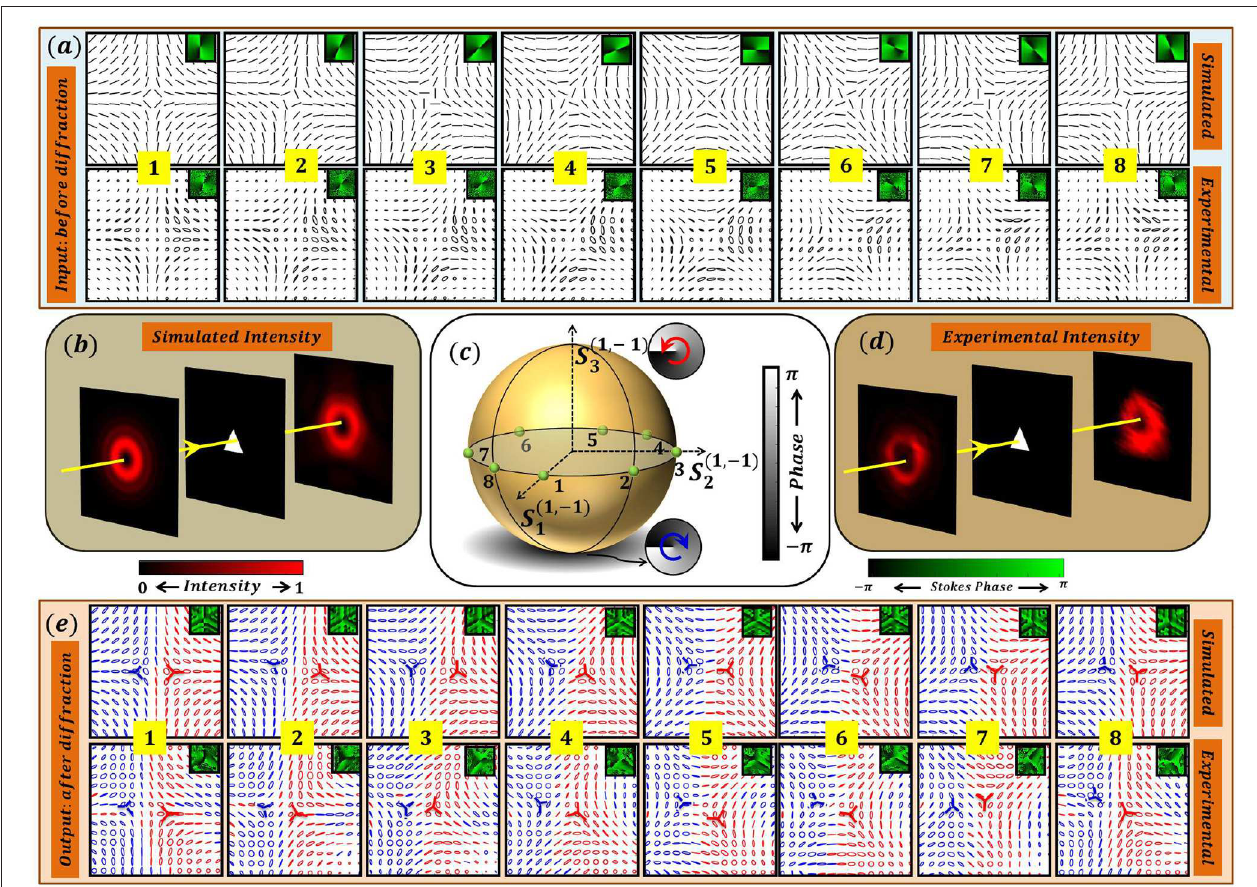
FIGURE 14 | Intensity degeneracy in the diffraction patterns of V-point beam with index η = − 1 through a triangular aperture. Simulated and Experimentally observed (a) input and (e) diffracted SOP distributions. (b) Simulation: Schematic of the setup with input intensity, aperture, and diffracted intensity. (c) Locations of input SOPs (shown in a,e ) labeled as 1 − 8 on a HOPS. All these SOPs when diffracted through triangular aperture produce same intensity patterns and hence exhibit degeneracy. (d) Experimental: Schematic of the setup with input intensity, aperture, and diffracted intensity. Note in this case, the V-points disintegrate into two stars of opposite handedness with I c = − 1 /